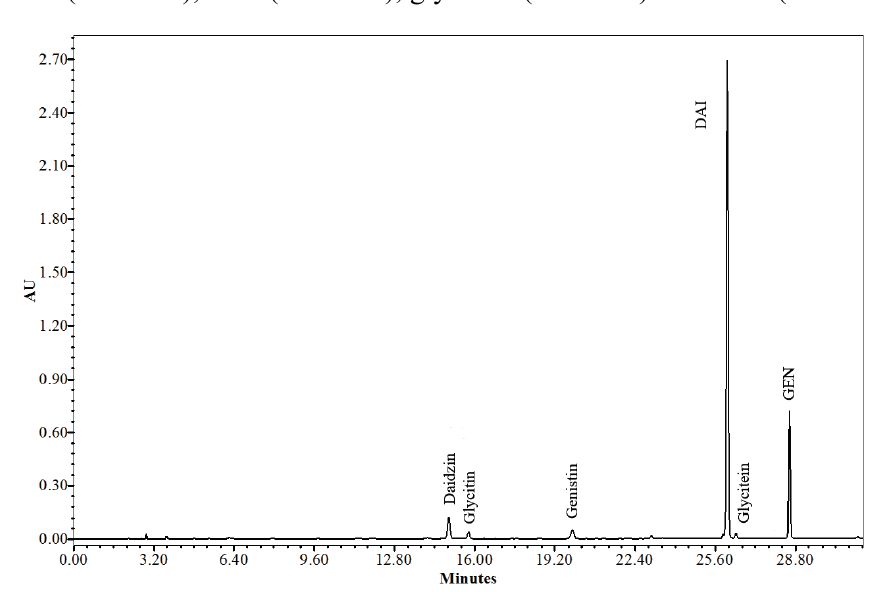
Figure 1. Chromatogram of SE extractive solution. Daidzin (15.5 min), glycitin (15.8 min), genistin (19.9 min), DAI (26.0 min), glycitein (26.5 min) and GEN (28.6